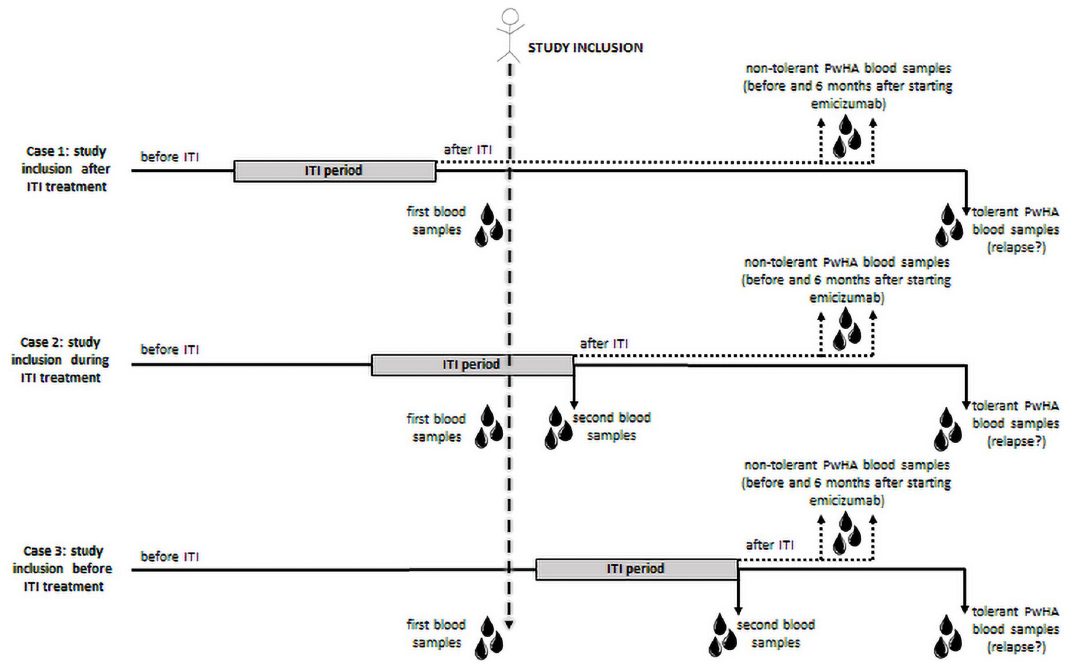
Fig 1. Illustrative chart of patients’ inclusion and collection of samples in the BrazIT Study. The inclusion of patients occurs before, during or after ITI. Blood samples are collected before and after ITI if patients are included before ITI initiation; during and after ITI if patients are included during ITI; and after ITI if patients are included after ITI. Another blood sample is collected during the follow up, until the end of the study. ITI, immune tolerance